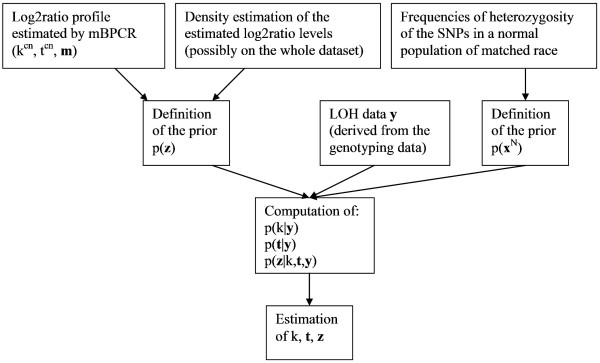
Scheme of the algorithm corresponding to Model 1. The graph shows the algorithm for the inference of Model 1. The scheme of gBPCR (i.e. Model 3) can be obtained by substituting p(z|k, t, y) with p(w|k, t, y) and by estimating w instead of z.